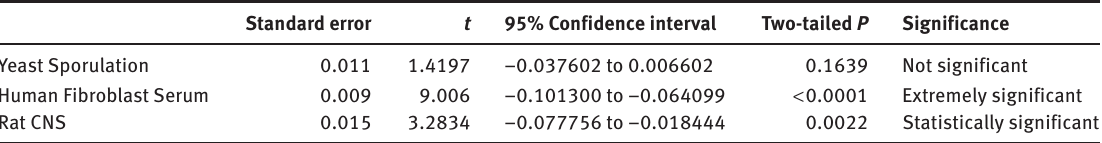
Table 13: Unpaired t Test Between the Best and the Second Best Performing Algorithms for Each Gene Expression Data Set Based on